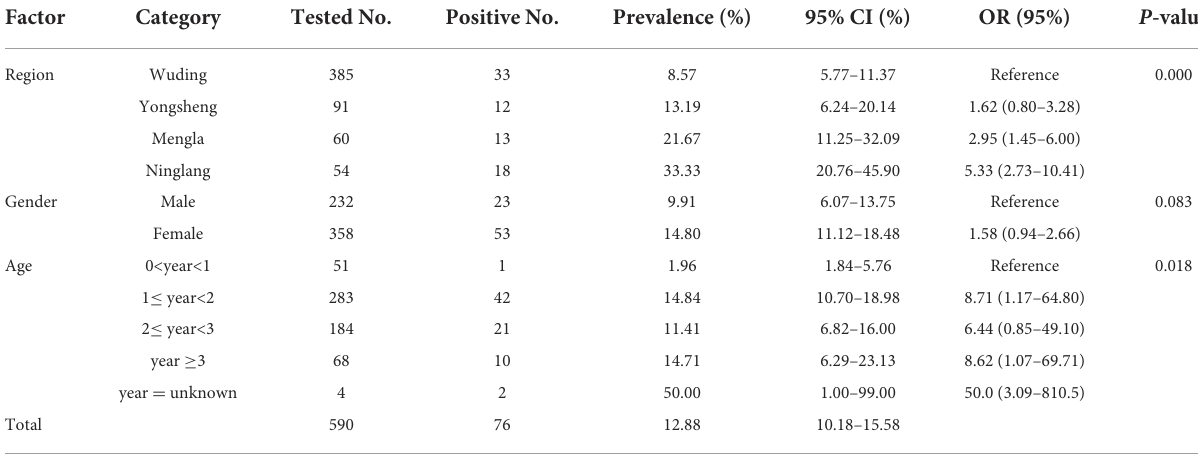
TABLE 2 Seroprevalence of Neospora caninum in black goats in Yunnan Province, Southwestern China. Factor